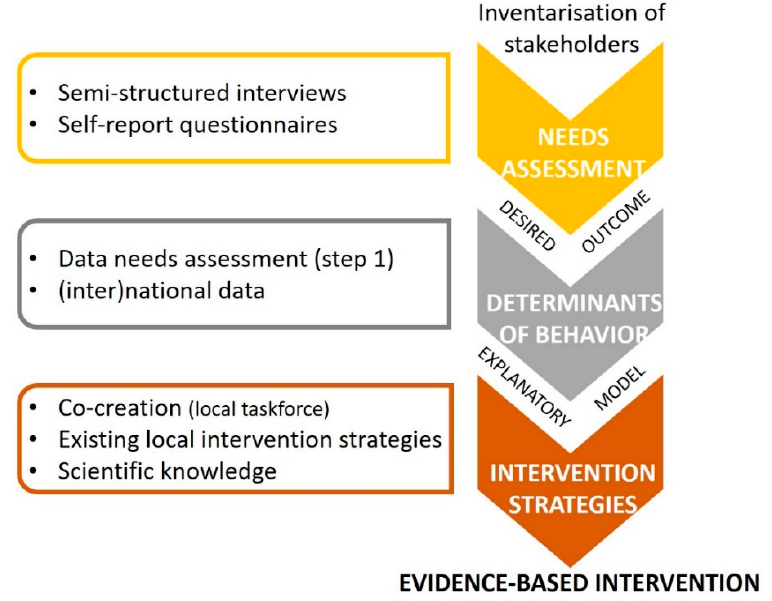
Figure 2. Three Steps Included in the Developmental Phase of the Community-Based Intervention LEF.